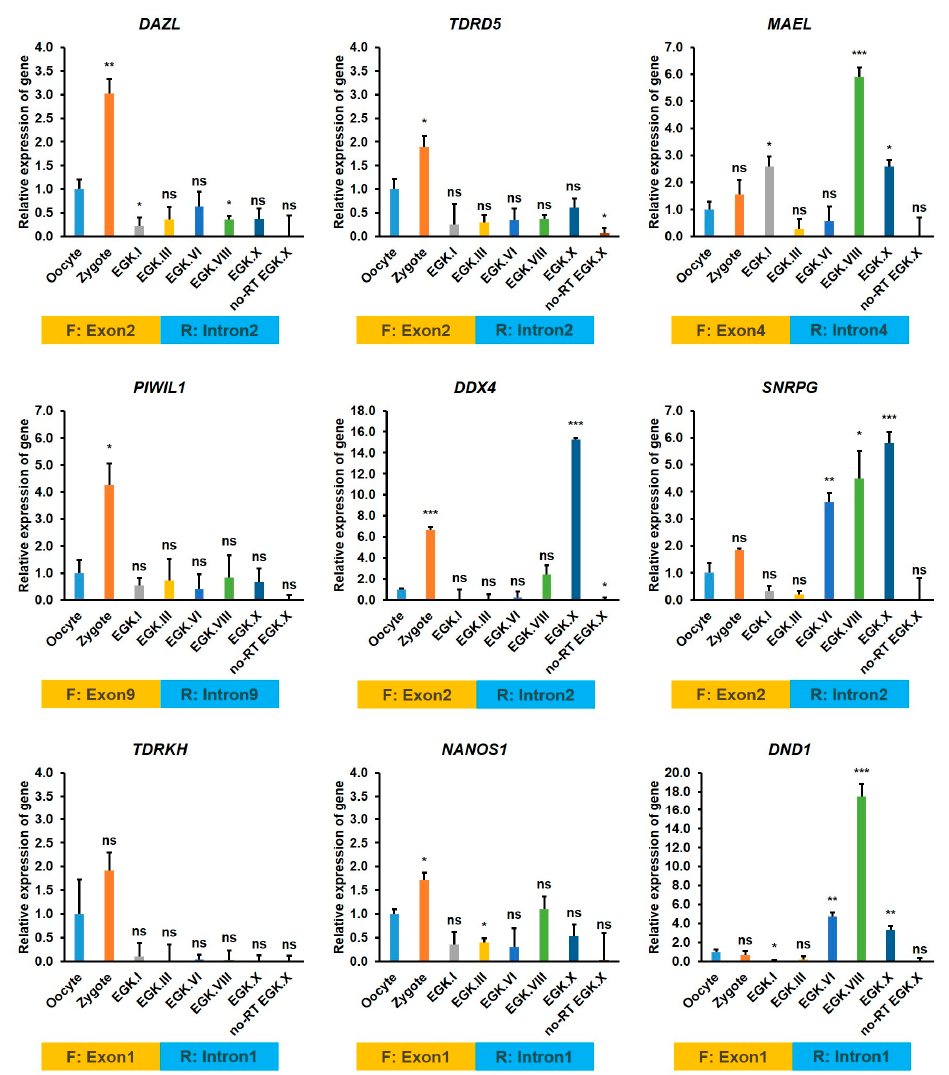
Figure 6. Exon–intron specific RT-qPCR validation of DAZL interacting genes during the intrauterine embryonic development in chicken. Total RNAs from the oocyte, zygote, and EGK.I to EGK.X stage embryos are reverse transcribed using the random hexamer. No reverse transcriptase (no-RT) negative control of EGK.X embryos are also prepared to monitor the genomic DNA contamination. Then, the cDNAs are amplified using the gene-specific forward and reverse primers. The forward primer (F) on a suitable exon region and the reverse primer (R) on the following intron region is designed with the GenBank sequences of each gene. qPCR is performed in triplicate with three independent samples. The relative quantification of the gene expression is normalized with the chicken GAPDH and a reference sample (oocyte) and analyzed by the 2 − ∆∆ Ct method. Significant di ff erences between the oocyte and other test samples are determined using the Student’s t -test. Statistical significance is ranked as * p < 0.05, ** p < 0.01, or *** p < 0.001. ns—not